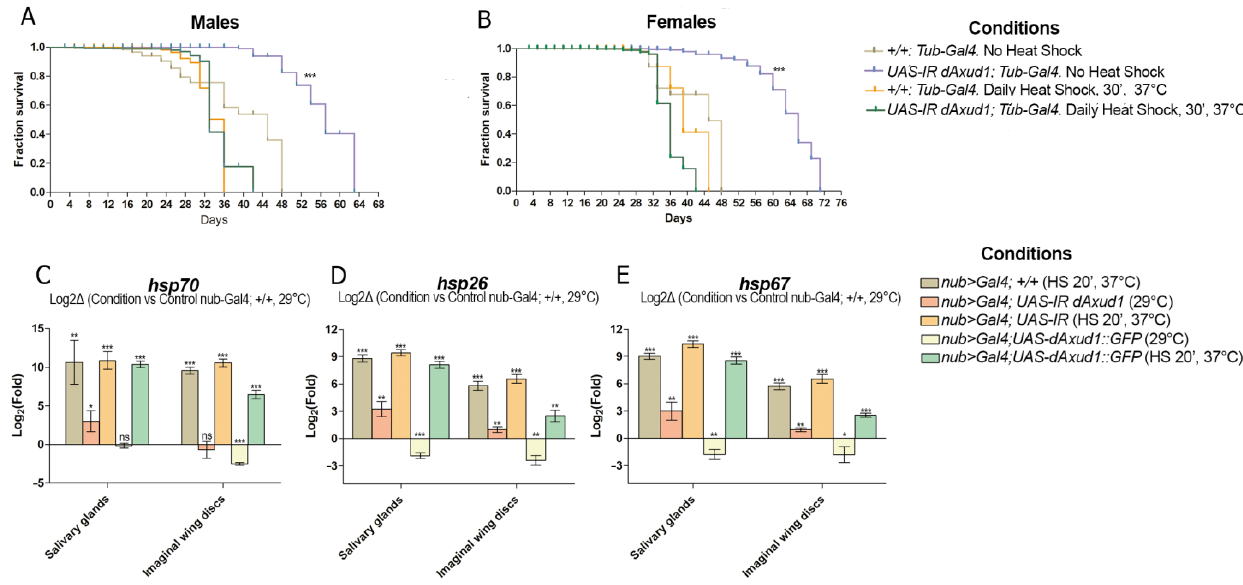
Figure 2. The impact of dAxud1 knockdown in lifespan. ( A , B ) represent the survival chart to depict the effect of dAxud1 knockdown ( yw; UAS-IRdAxud1/+; Tub > Gal4/+ ) vs. control genotype ( yw; +/+; Tub > Gal4/+) when they are exposed to heat shock episodes of 37 ◦ C for 30 min every day. NHS: non heat shock; DHS: daily heat shock. ( C – E ) represent the relative expression of three heat shock genes, hsp70B (all paralogs), hsp26 , and hsp67 , in two different tissues. The expression was analyzed on five conditions and compared to control conditions, including dAxud knockdown ( nubbin Gal4/+; UAS-IR-dAxud1 ) and DAxud1 overexpression ( nubbin Gal4/+; UAS-DAxud1-GFP). The